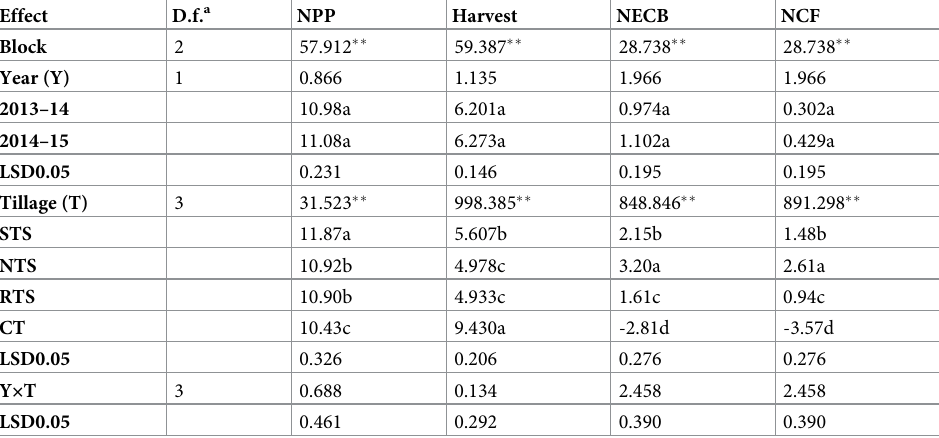
Table 5. ANOVA of net primary productivity (NPP), harvest, net ecosystem carbon balance and net carbon flux during the wheat- and maize- growing seasons during the 2013–2015 rotation.